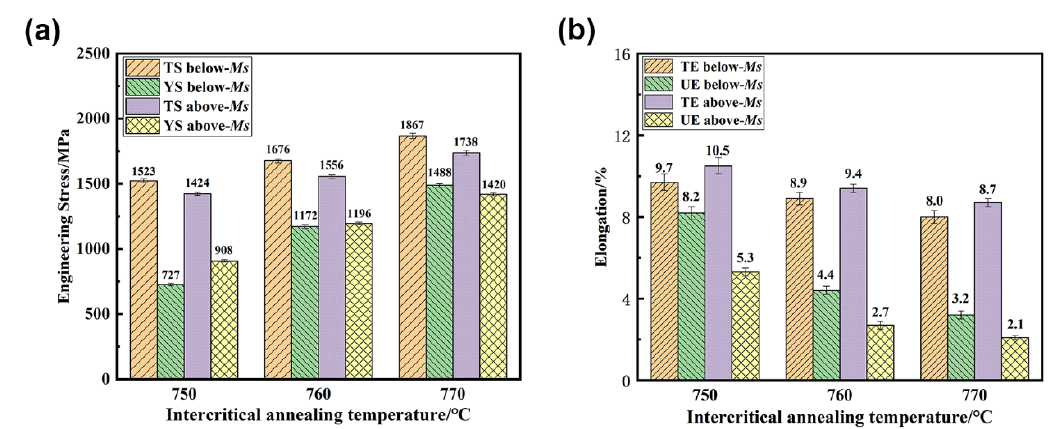
Figure 8. ( a ) Tensile strength (TS), yield strength (YS), ( b ) total elongation (TE) and uniform elongation (UE) after different processes.